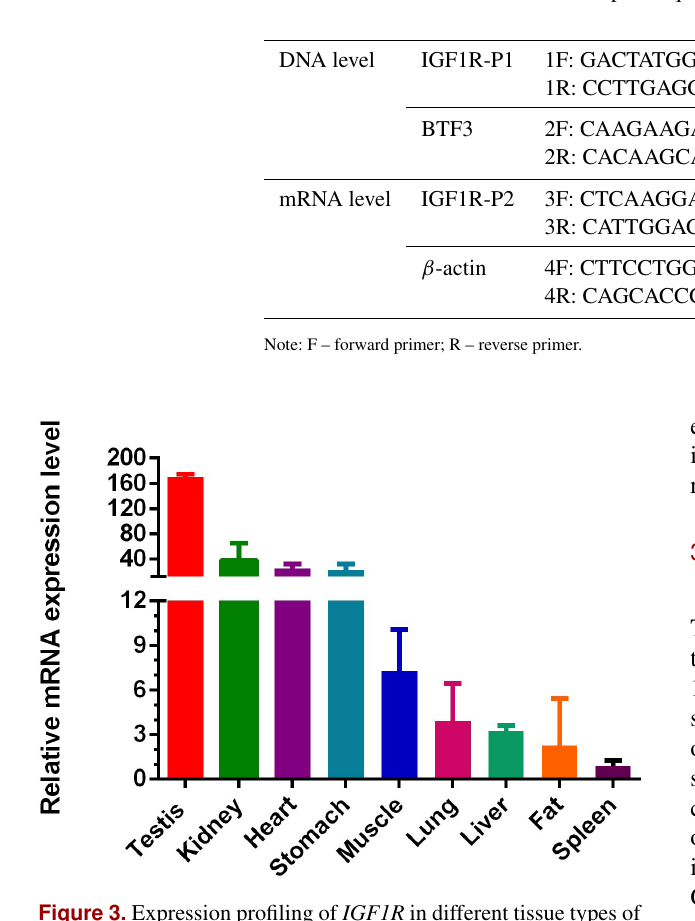
Table 1. Primer pairs designed for the genes used in this study. Gene Primer pair sequences (5 (cid:48) –3 (cid:48) )